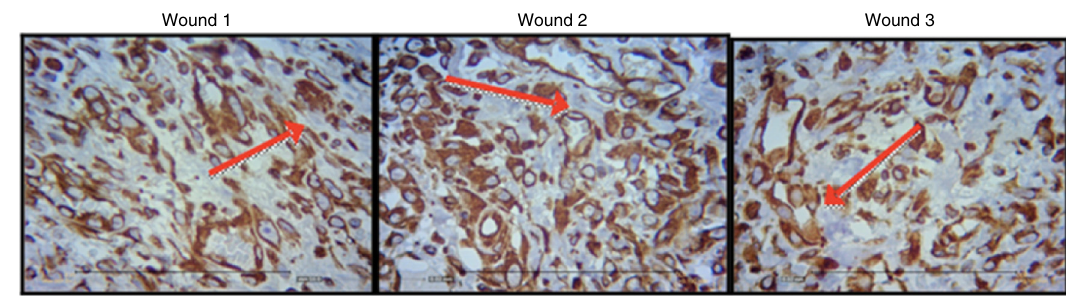
Photomicrograph of vimentin --- in which macrophages, fibroblasts, and vessels are evaluated, on the third day of evolution, in the wounds 1, 2, and 3 (VIM × 200).